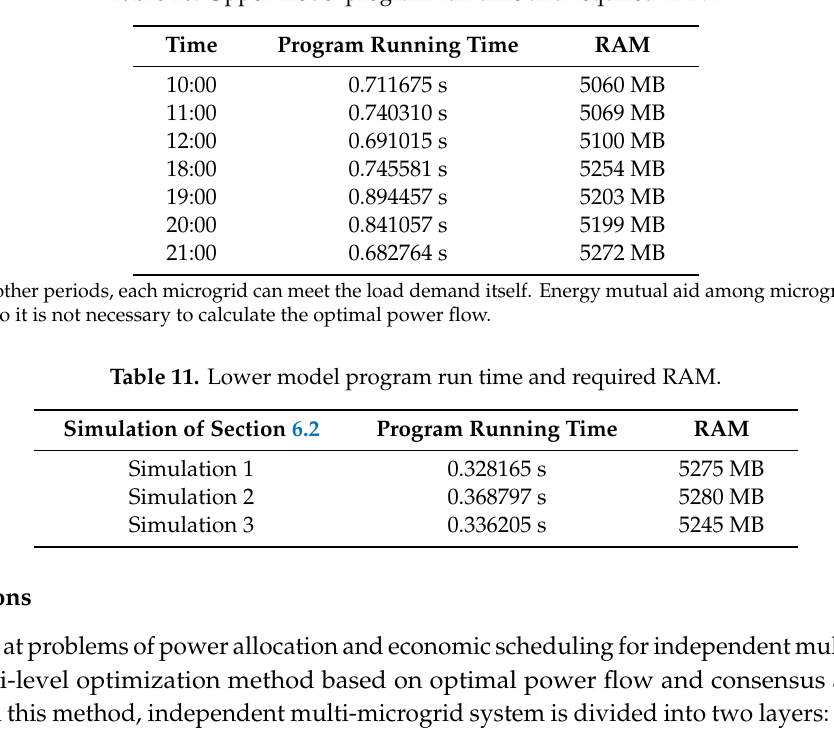
Table 10. Upper model program run time and required RAM.